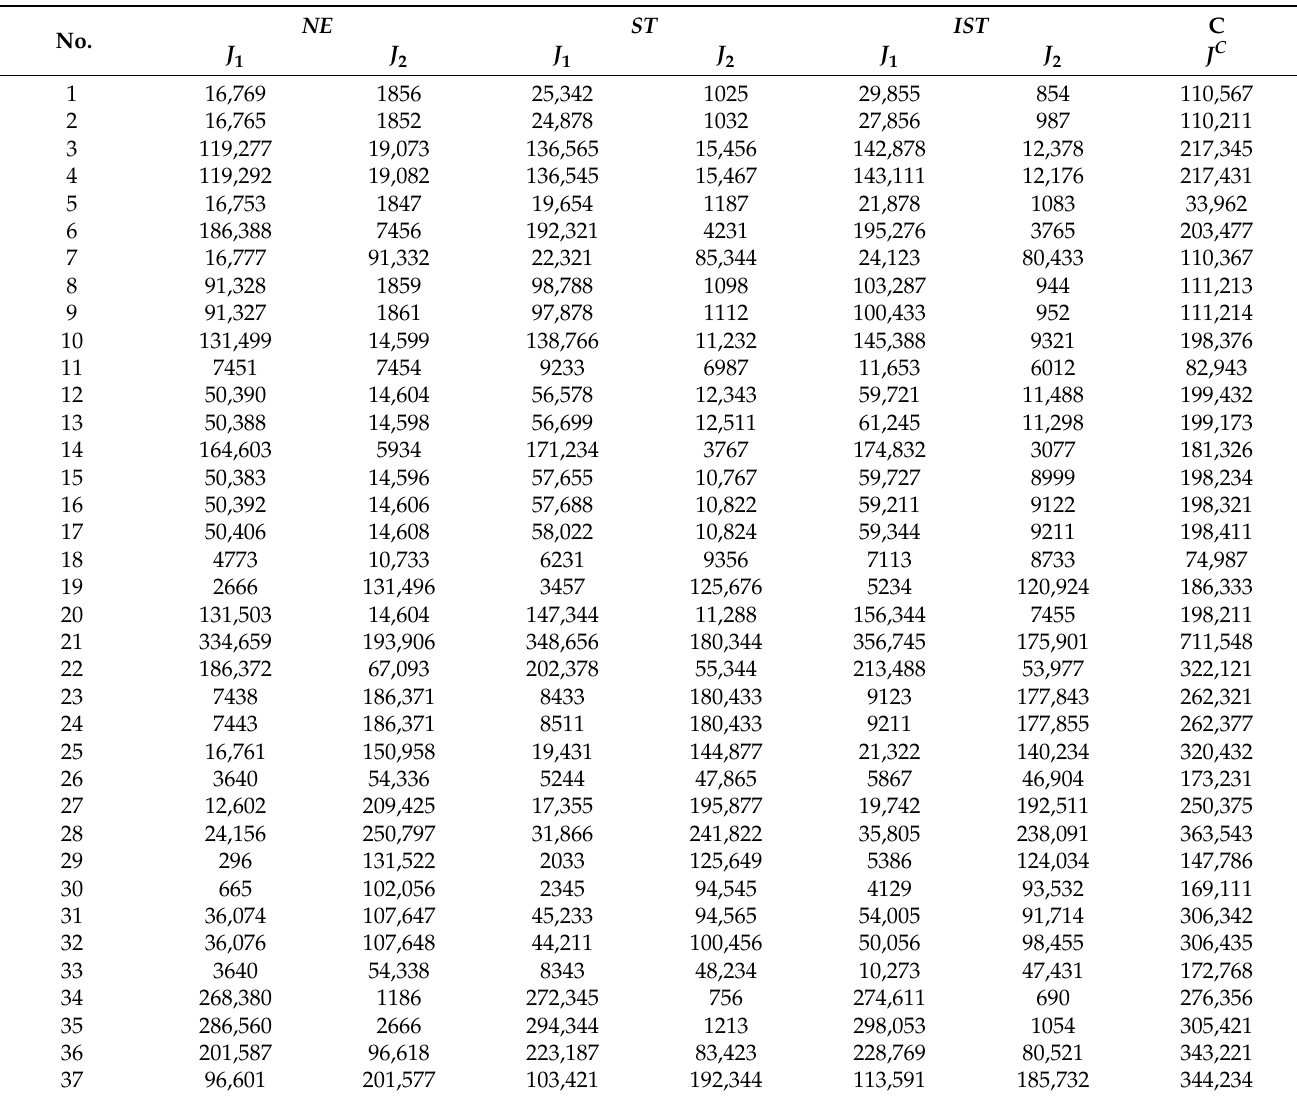
Table 4. Payoffs of arbitrary agents for different information